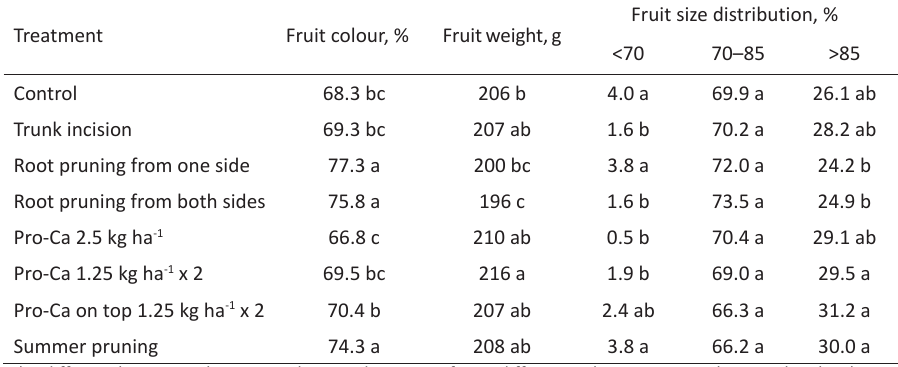
Table 3. Effect of growth control technologies on the fruit surface colour, weight and fruit size distribution of apple cv. ‘Rubin’, average of 2015–2018